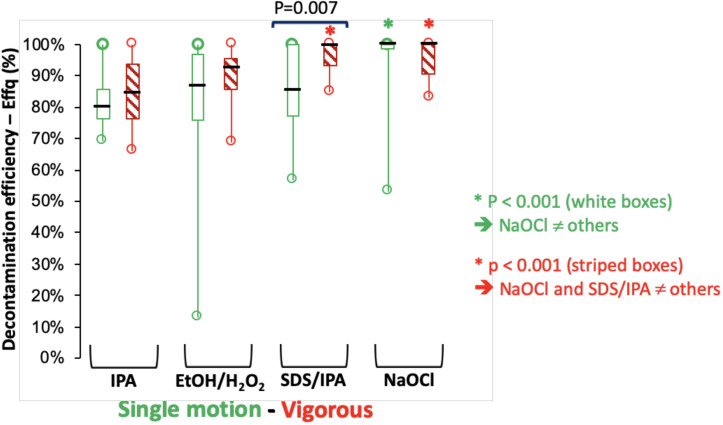
Comparison of the overall efficiency of four decontamination or deactivation solutions according to their application modalities.White boxes represent standard decontamination and striped boxes represent vigorous decontamination. The solutions compared are 70% isopropanol (IPA), an admixture of ethanol-hydrogen peroxide (91.6–50.0 mg/g), an admixture of 10−2 M sodium dodecyl sulfate/isopropanol (80/20) and sodium hypochlorite (NaOCl). Significant differences are observed for single standard motion between NaOCl and the other solutions and for vigorous application for both NaOCl and SDS/IPA compared to the two other solutions.